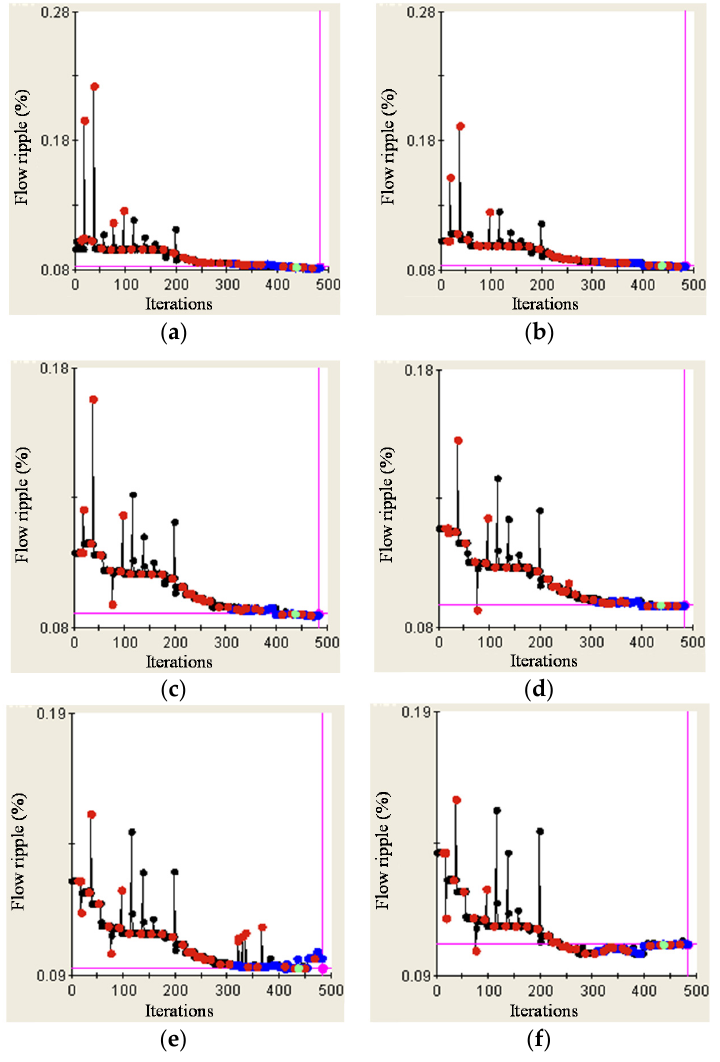
Figure 7. Iteration process of flow ripple: ( a ) 20 MPa; ( b ) 24 MPa; ( c ) 28 MPa; ( d ) 32 MPa; ( e ) 36 MPa; ( f ) 40 MPa.